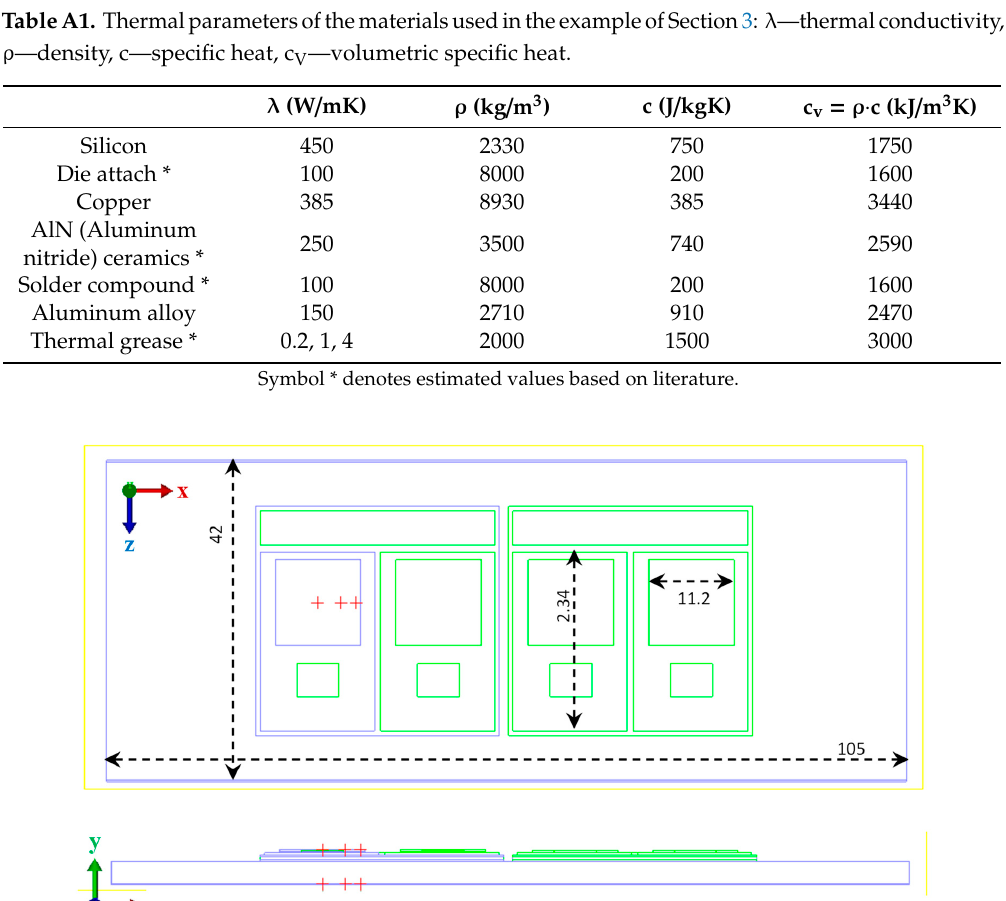
Figure A2. Power module on a cold plate from the simulation study in Section 3, excerpt from Figure A1. Temperature monitor points are marked as “+”. Figure A3 demonstrates a TDIM measurement of an IGBT module by a thermal transient tester. The measurement environment is a water-cooled cold plate, wetted by thermal grease in the figure. More images of the equipment can be found in References [20,21].